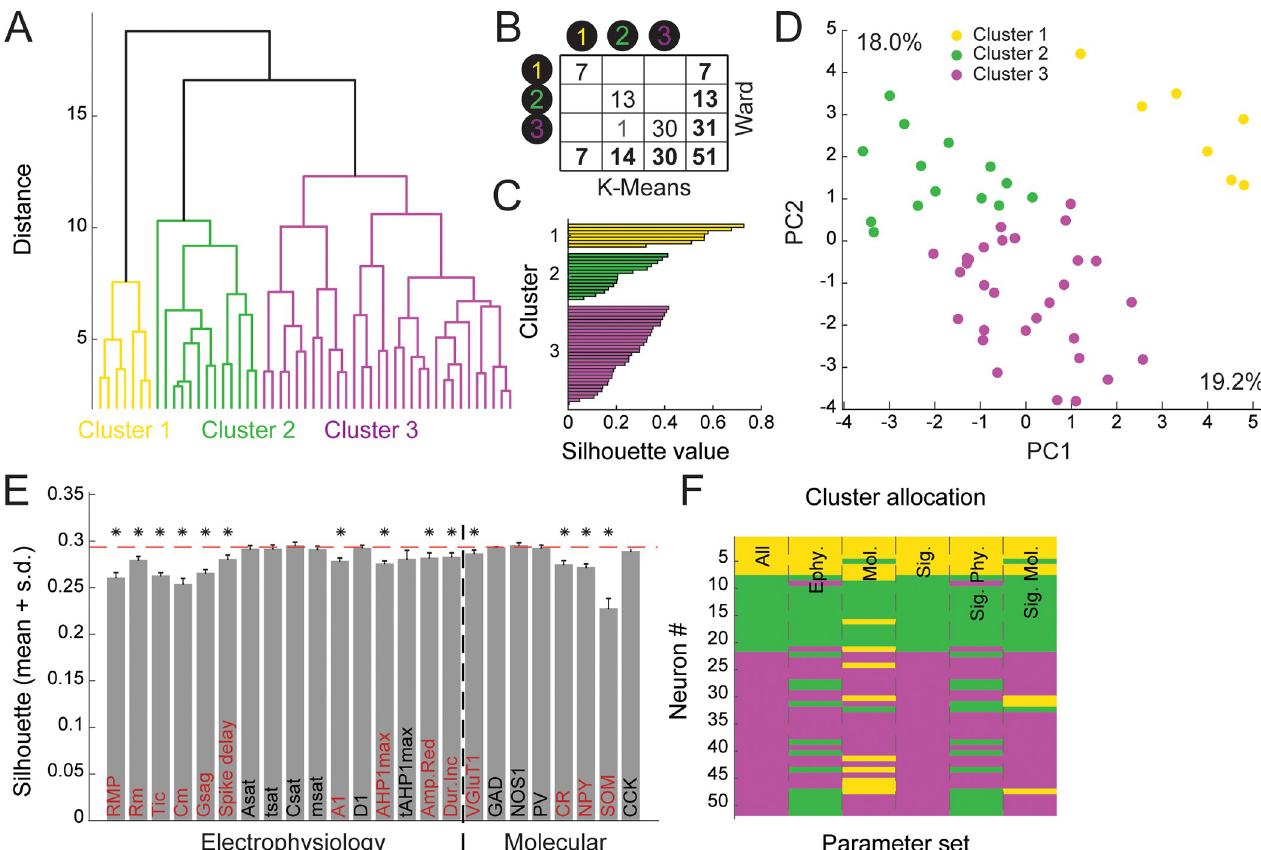
Fig 2. Hilar GABAergic neurons segregate into 3 main clusters. A: Ward’s unsupervised clustering applied to 51 hilar GABAergic neurons based on electrophysiological and molecular properties characterized with single cell RT-PCR. 16 electrophysiological and 8 molecular parameters were used. The analysis disclosed 3 clusters of cells. The x-axis represents the individual cells and the y-axis the distance of aggregation. B: Matching table of Ward clusters and clusters generated by the K-means algorithm initialized on Ward clusters centroids. The K-means algorithm corrects cells miss-assigned by Ward method generating non-overlapping clusters. C: Cluster silhouettes plot: Each individual cell is represented by a horizontal line. No negative silhouette values were observed, indicating no potential miss-assignment. D: Two-dimensional projection of hilar GABAergic neurons on the first and second principal components (PC) following Principal Component Analysis. Percentages beside the x and y axes indicate the fraction of the sample variance explained by the first and second principal components respectively E: Impact of electrophysiological and molecular parameters on clustering quality (see Methods for parameter details). The values of each parameter were shuffled 1000 times. Parameters were considered significant ( � ; red label) when shuffling resulted in a decrease in mean silhouette value more than 95% of the times. F: Cluster allocation is robust to parameter sets. Allocation of each neuron (y-axis, color code as in A) using the following parameters sets (x-axis from left to right): 1. All, 2. Electrophysiological, 3. Molecular, 4. Significant, 5. Significant Electrophysiological, 6. Significant Molecular.